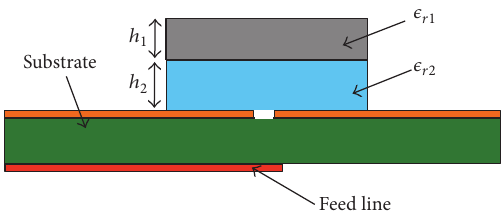
Figure 13: Cross-sectional view of a two-layer rectangular DRA for size reduction as suggested in